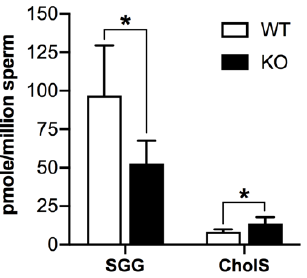
Figure 10. Changes of sulfolipid levels in sperm from 8-month-old Arsa KO mice, as compared with sperm from age-matched WT mice. Two main sperm sulfolipids, SGG and cholesterol sulfate (CholS) were quantified by ESI-MS/MS-MRM. Results were from three replicate analyses. In each analysis, 3 and 10 WT and Arsa KO mice were used to prepare Percoll-gradient-centrifuged sperm, respectively, from which lipids were extracted for lipidomics work. * denotes p < 0.05.